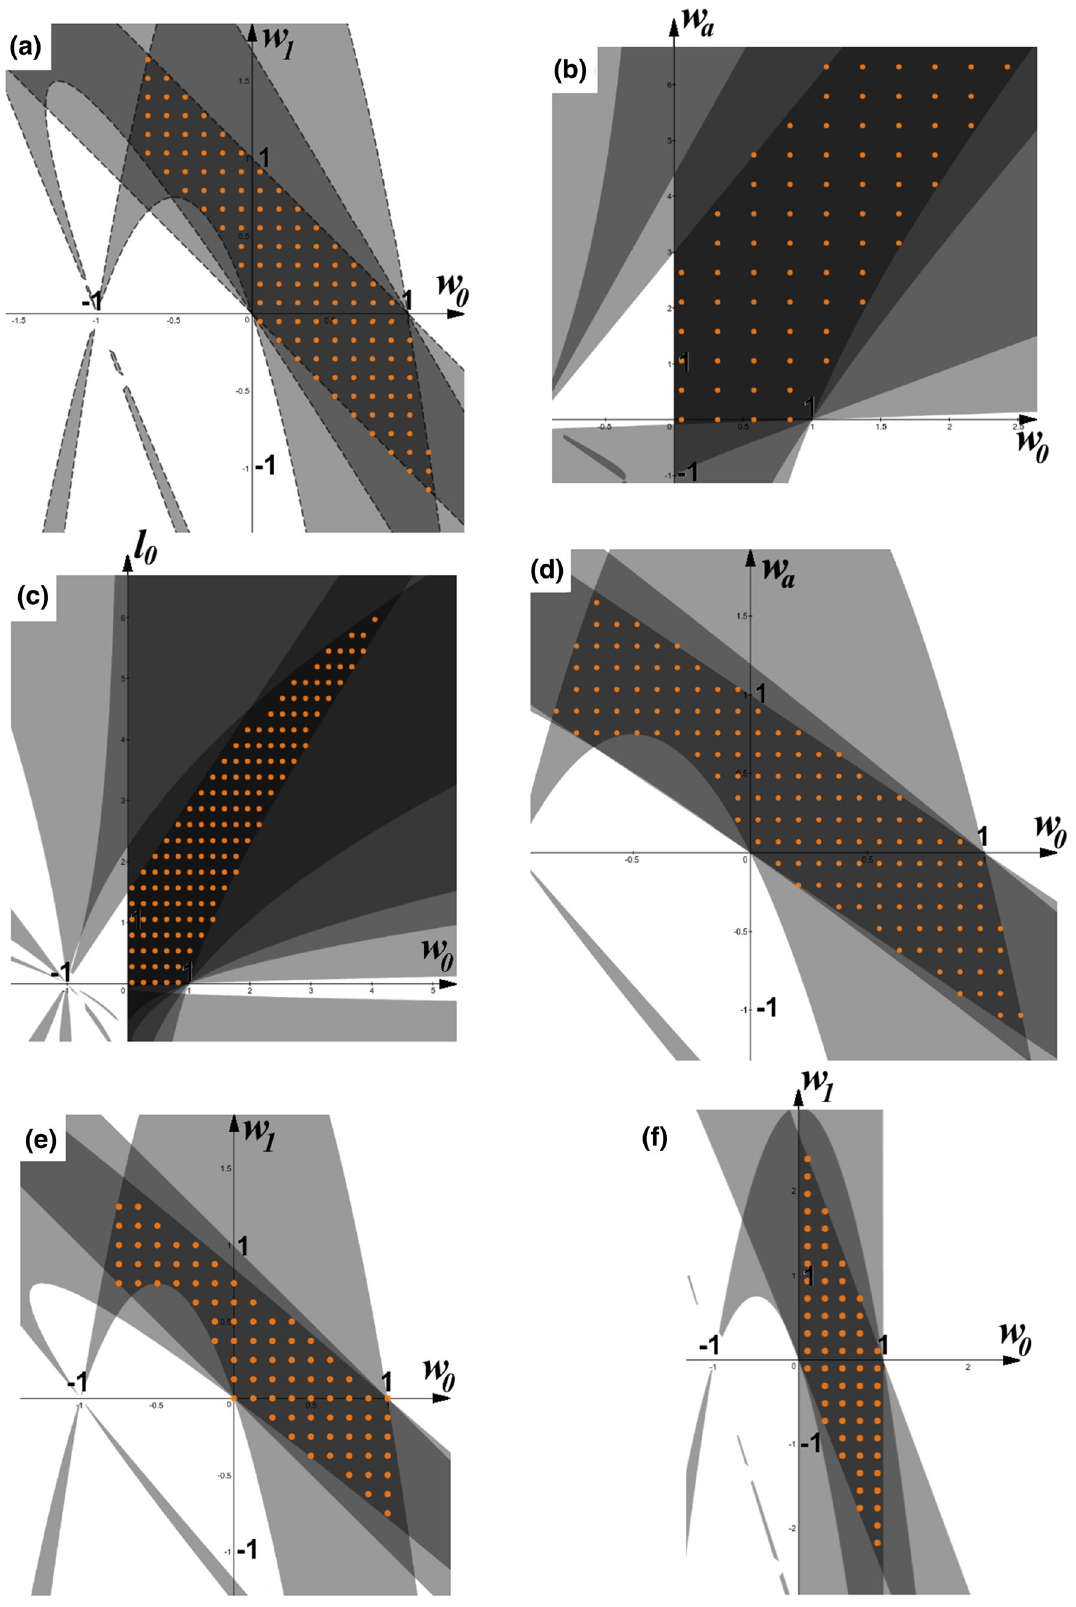
Fig. 1 The allowed parameter regions for two-parameter models [20, 21] in plot (a) , [23] (model 1) in plot ( b ), [23] (model 2) in plot ( c ), [37] (model 1) in plot ( d ), [28] in plot ( e ) and [40] in plot ( f ). In all plots the